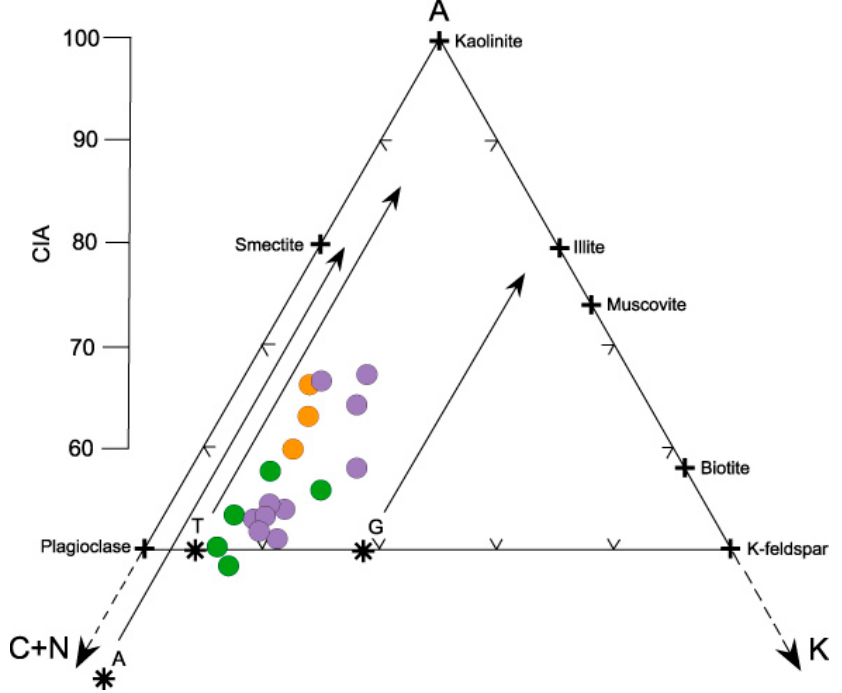
Figure 6. Molar Al-(Ca + Na)-K diagram [26] showing predicted weathering trends and chemical index of alteration (CIA) values for biotite gneiss from the New Jersey Highlands. Symbols as in Figure 5. Asterisks are average compositions of Mesoproterozoic granite (G), tonalite (T), and amphibolite (A) from the Highlands [15].